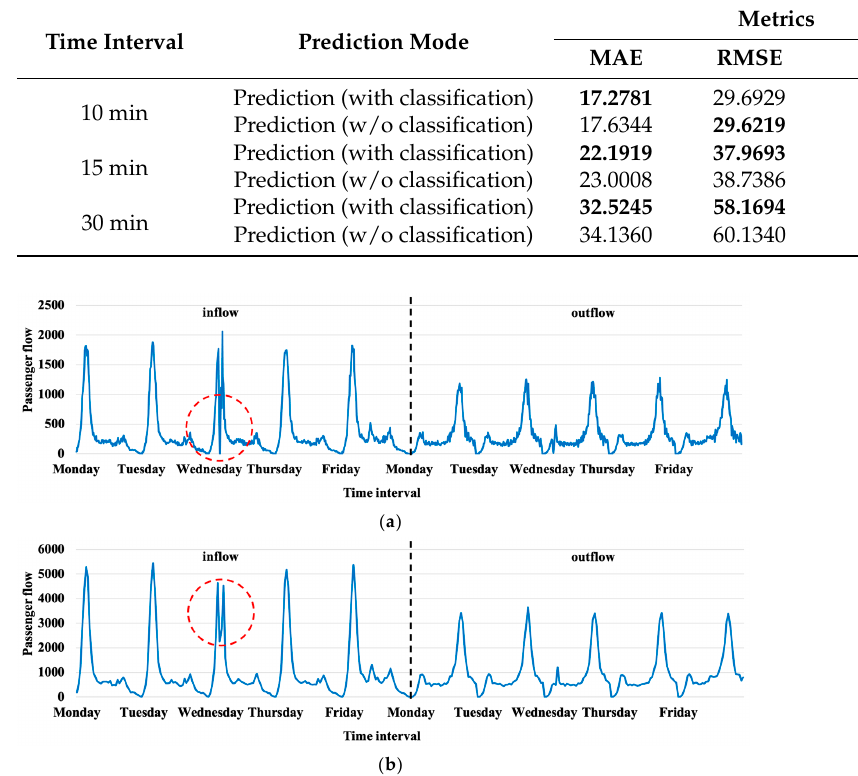
Figure 6. Inflow at No.1 Stations in the Beijing metro. ( a ) 10 min time interval; ( b ) 30 min time inter-